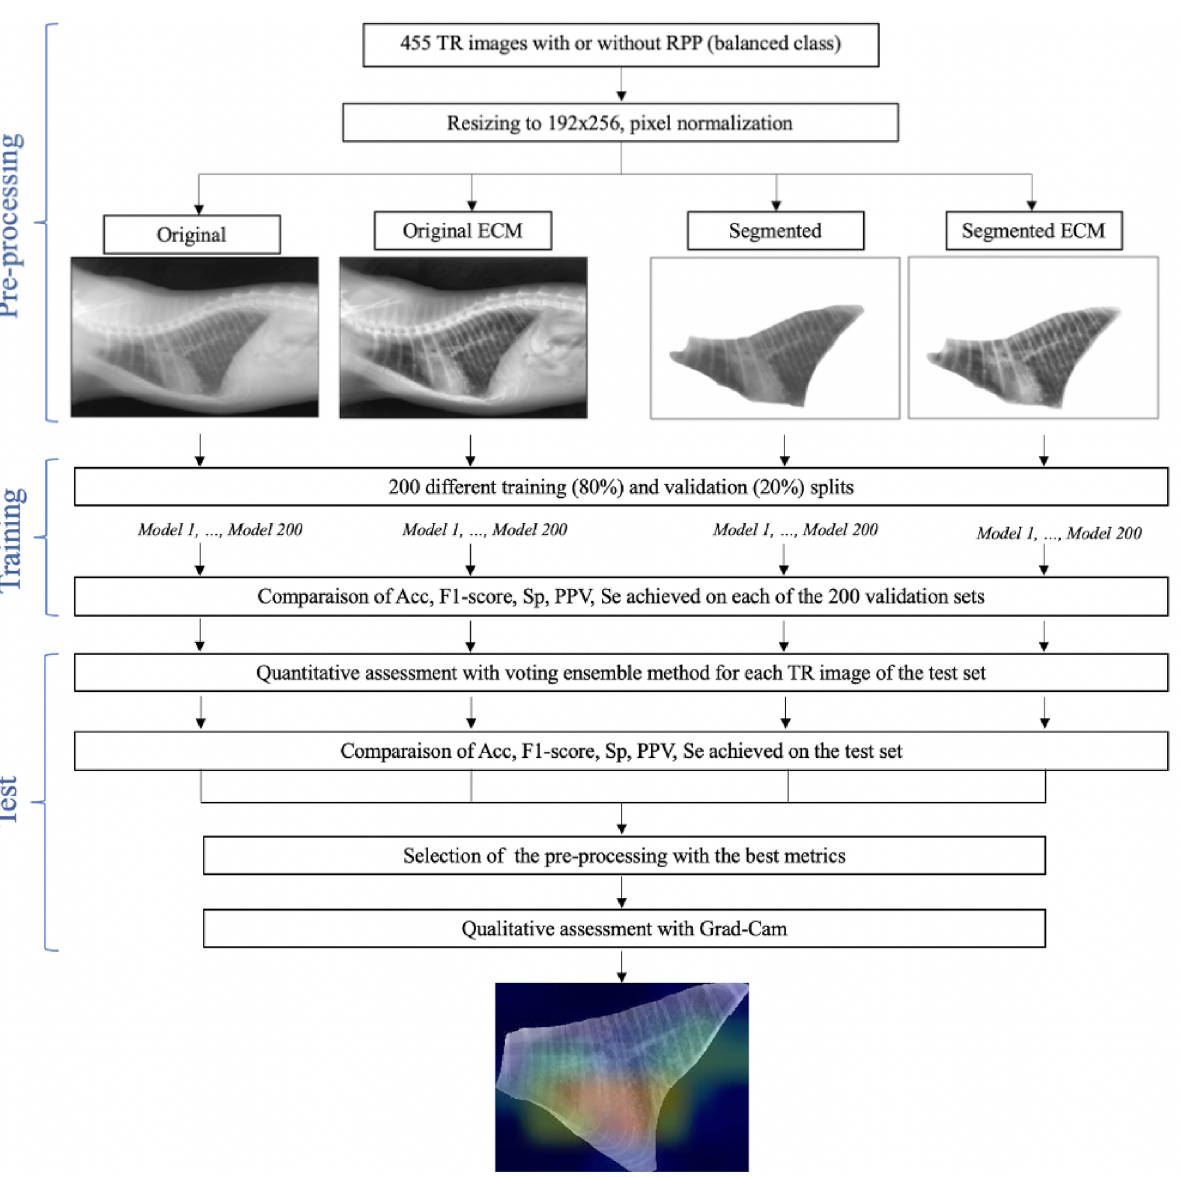
Figure 4. Workflow used in the study for detection of RPP in TR image. Model 1, …, Model 200 : models fine- tuned with the 200 random shuffles